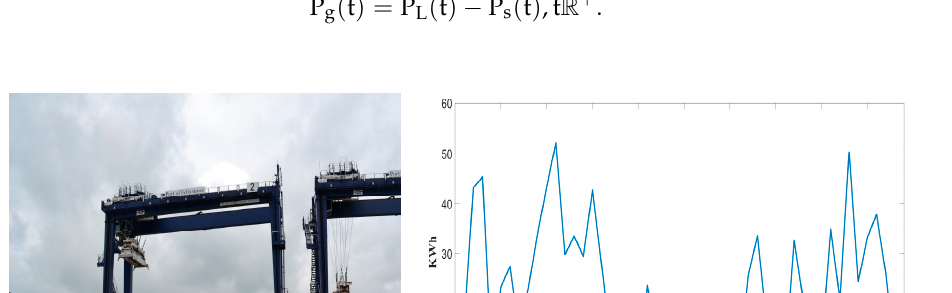
Figure 2. The power flow directions of the electrified RTG crane equipped with ESS. 2.1. The Energy Storage System The primary energy source in the electrified RTG crane model is a substation (11 kV/415 V). The secondary side of the substation is connected to the DC bus in the crane system through a diode rectifier. In this paper, the Energy Storage System (ESS) is located at the low voltage side (415 V) in order to minimise the peak power and cost, as shown in Figure 3, at the substation side based on the real-time electricity price cost through the proposed optimal and Model Predictive Control (MPC) controller. As in [2,15,18], the ESS used in this paper is described by Equations (2)–(8): E (cid:2929) (t) = E (cid:2929) (t − 1) + η(cid:3556) ( P (cid:2929) △ t ESS (cid:2913)(cid:2911)(cid:2926)(cid:2911)(cid:2913)(cid:2919)(cid:2930)(cid:2935) ).